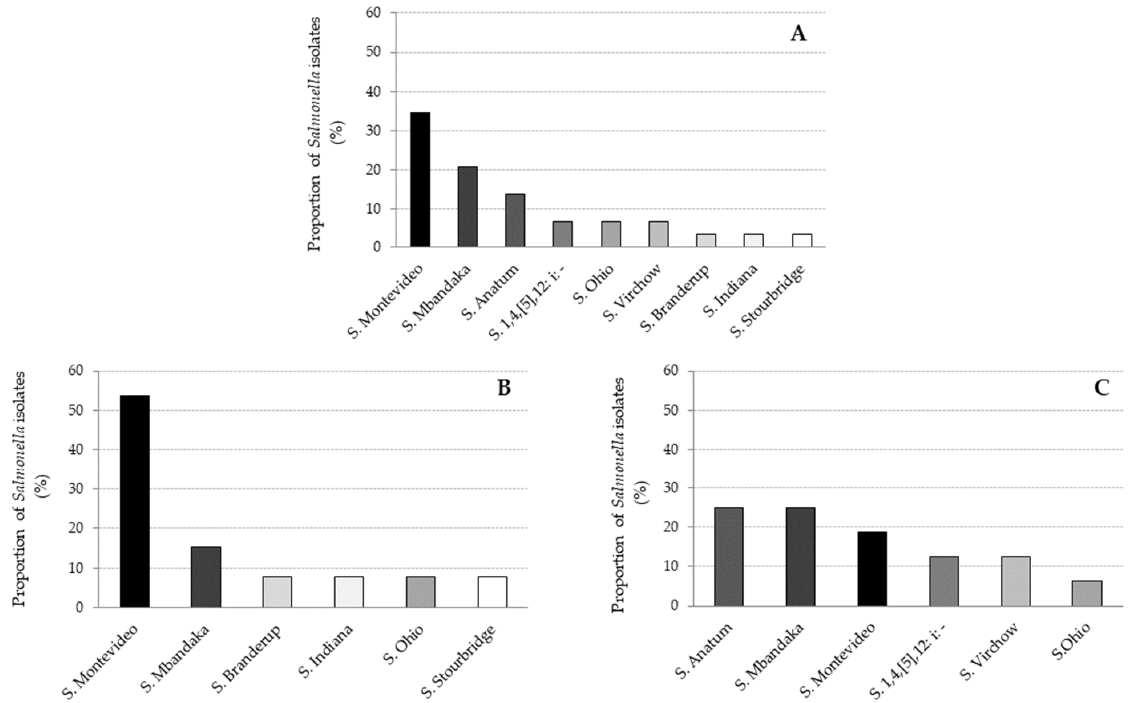
Figure 2. Main Salmonella serotypes found in the intestinal contents from all sampled animals ( A ), adult cattle ( B ) and calves ( C ). Each color represents one serotype of Salmonella .